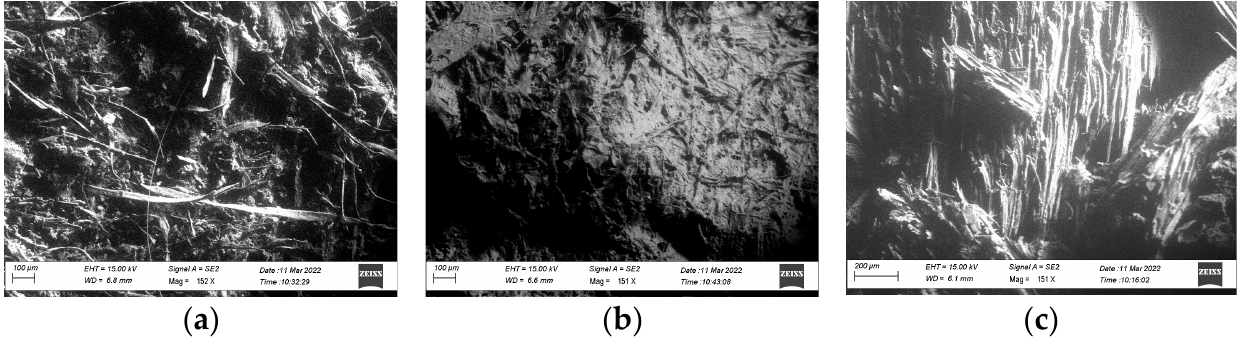
Figure 3. Morphology of the aggregates before mixing: ( a ) co ff ee grounds, ( b ) fava bean residues, ( c ) sawdust powder. Mean magni fi cation level 1000 kx.